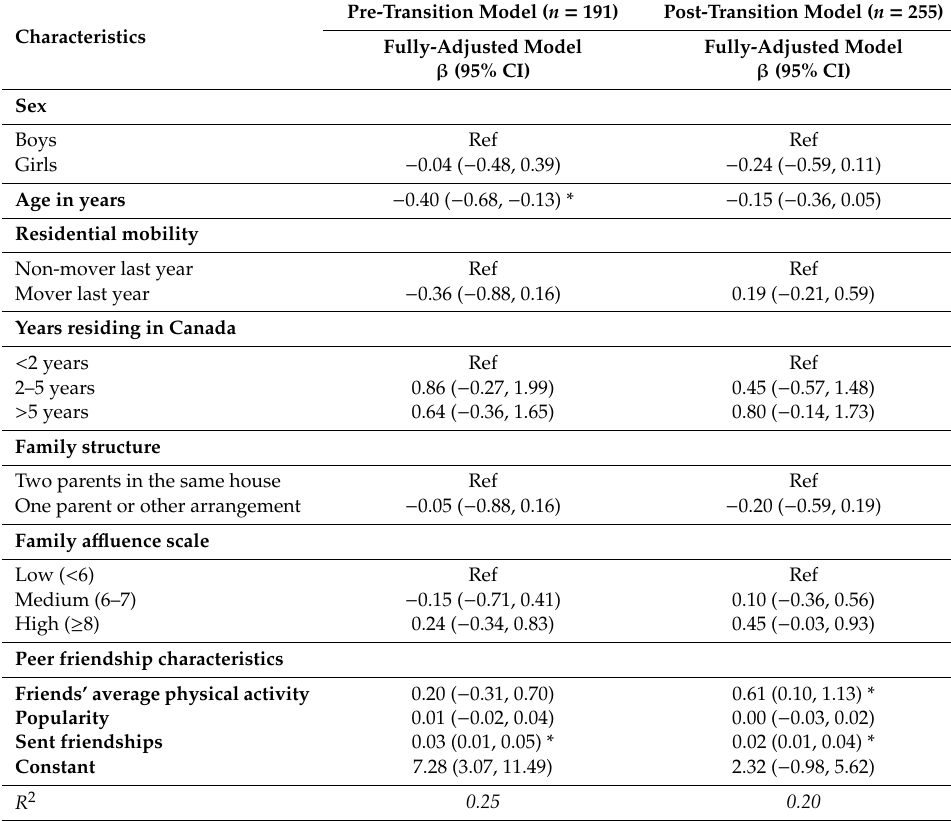
Table 3. Multivariable linear regression estimates ( β ; 95% CIs) for associations between physical activity, friendship characteristics, and sociodemographic